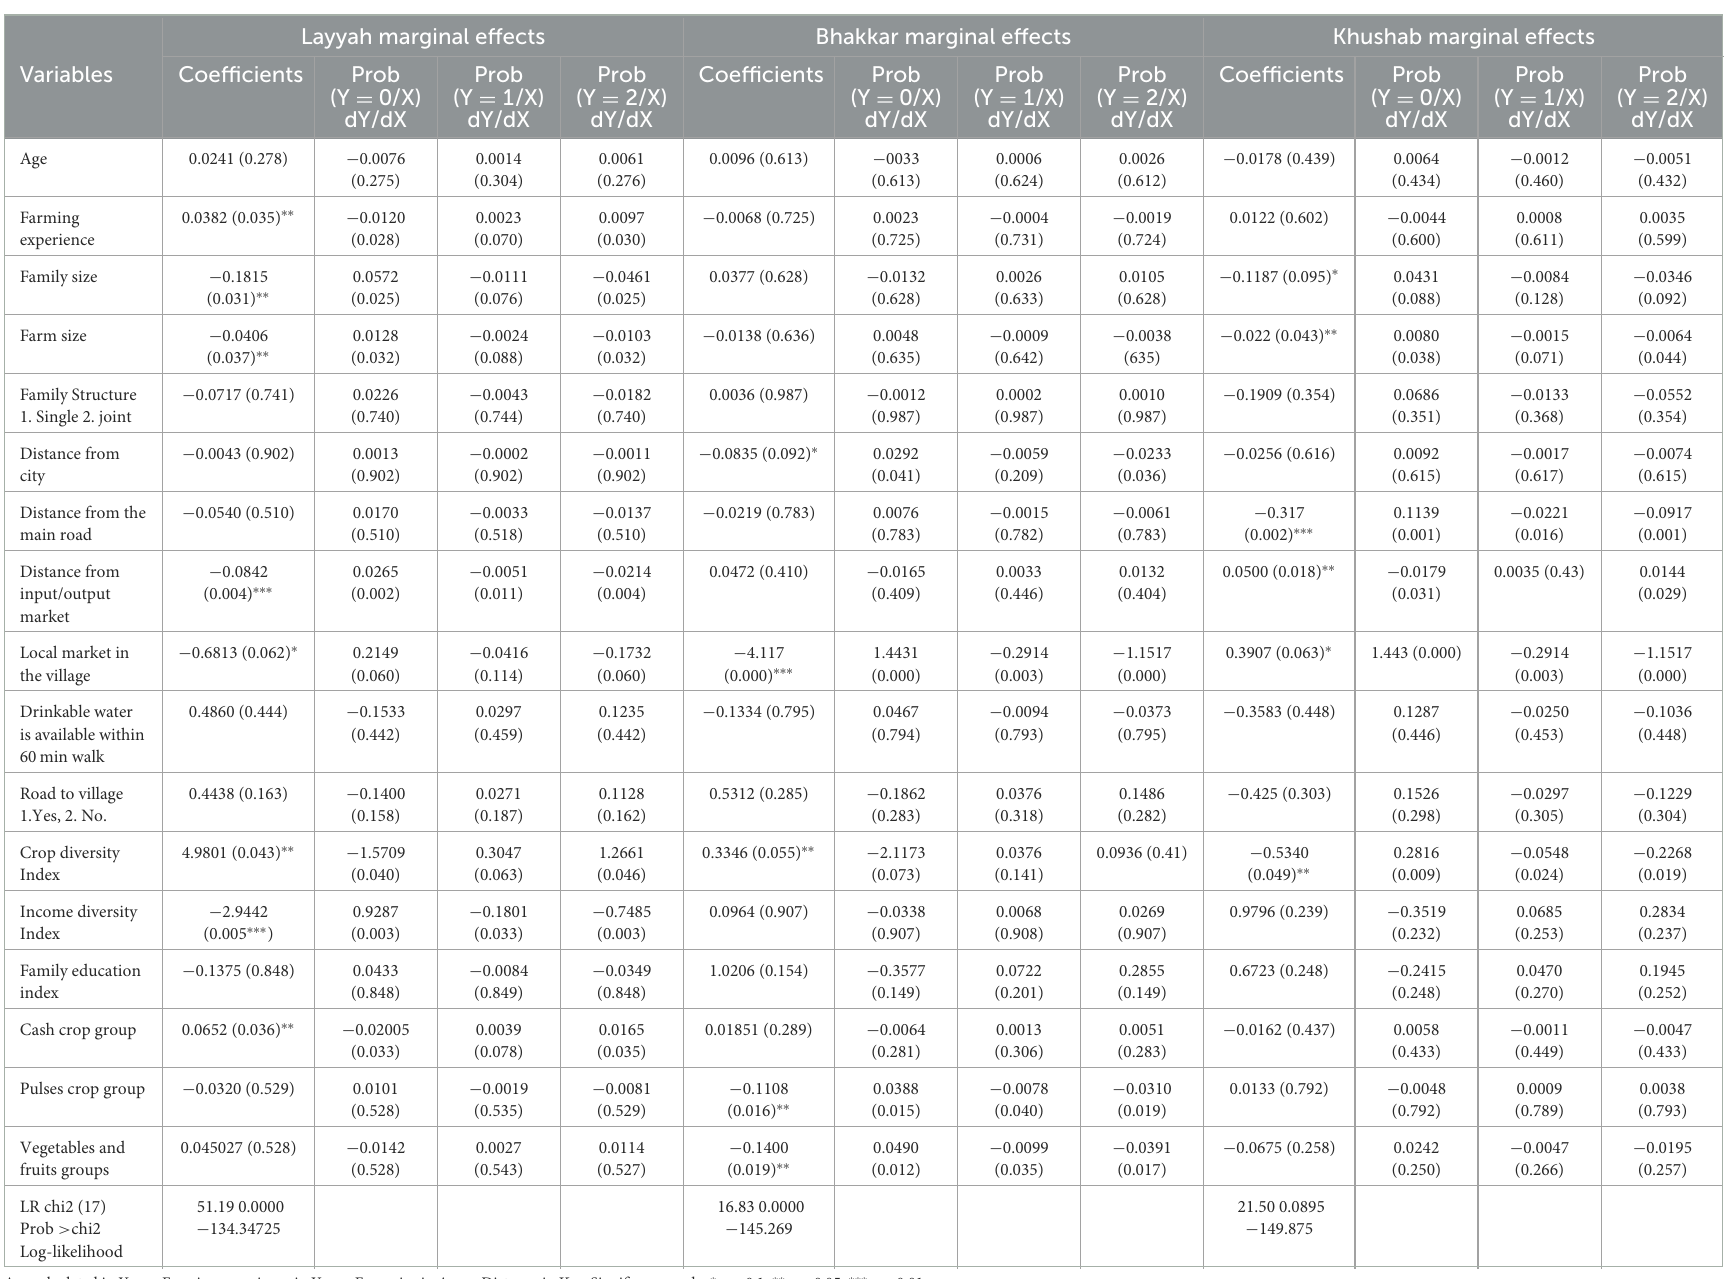
TABLE 2 Results of dietary diversity among men as assessed by an analysis of agricultural and socioeconomic